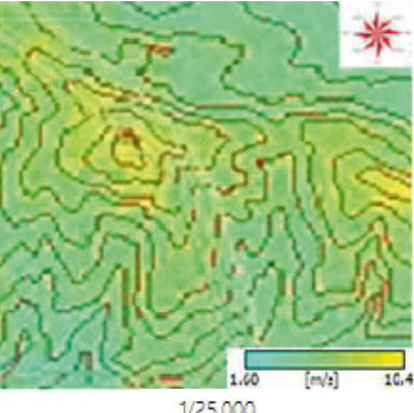
Figure 6: Average wind severity map calculated in the area.